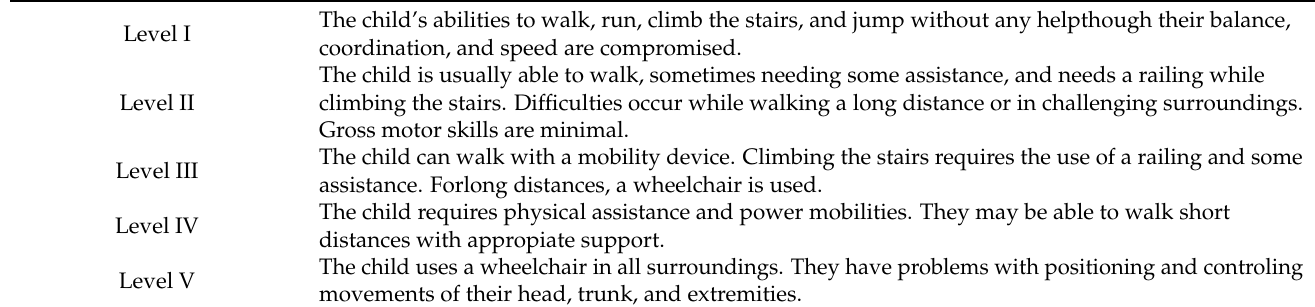
Table 5. Gross Motor Classification